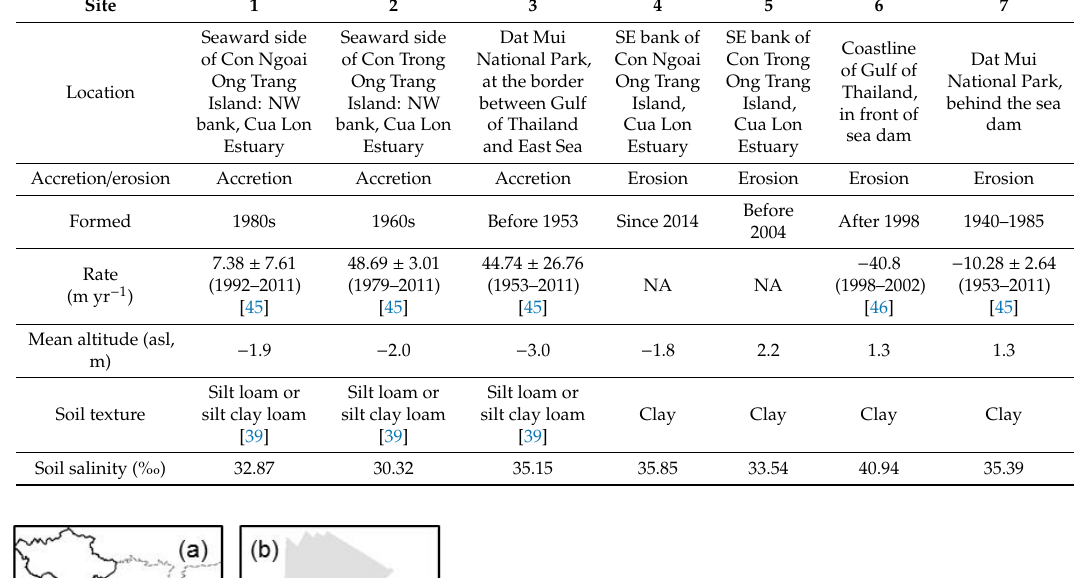
Table 1. Topographic and coastal characteristics of the study sites.